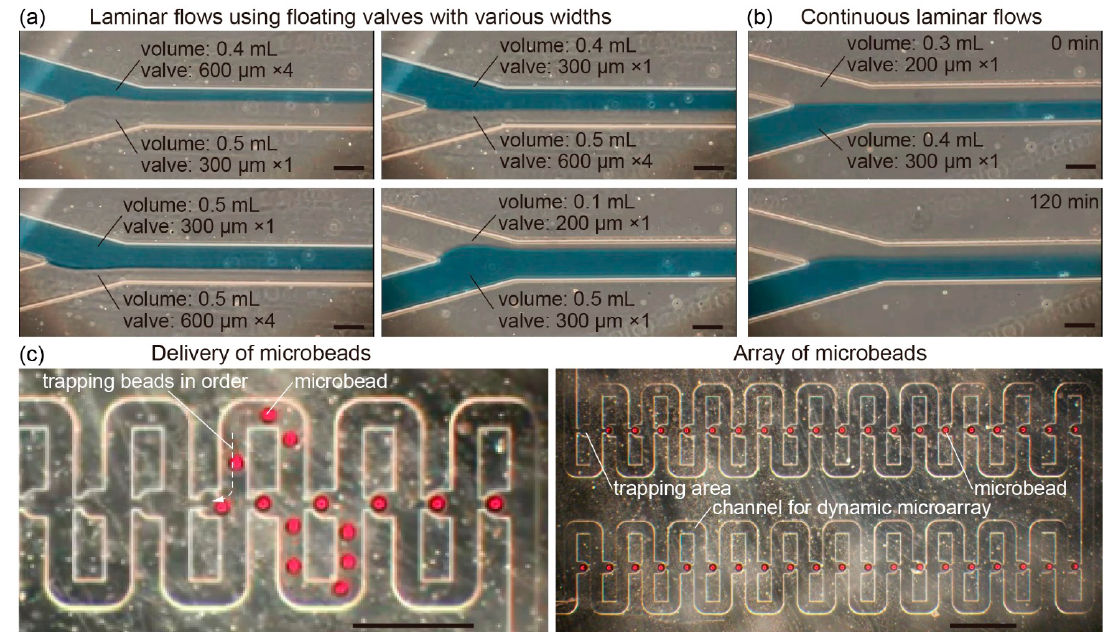
Figure 5. ( a ) Laminar flows formed by using balloon pumps with various floating valves and volumes of stored liquids; ( b ) continuous formation of the laminar flows; and ( c ) formation of an array of microbeads in the dynamic microarray device using the balloon pump with four 600 μm width floating valves and 0.3 mL of stored water. Scale bar: (a,b) 100 μm; and (c) 500 μm.